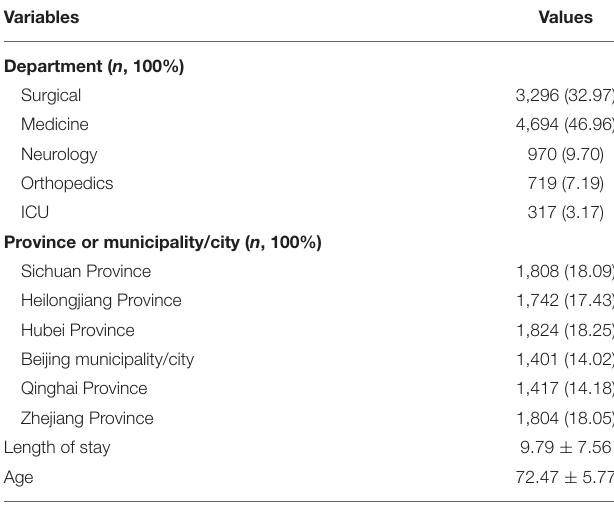
TABLE 1 | Demographic characteristics of the participants ( N = 9,996).